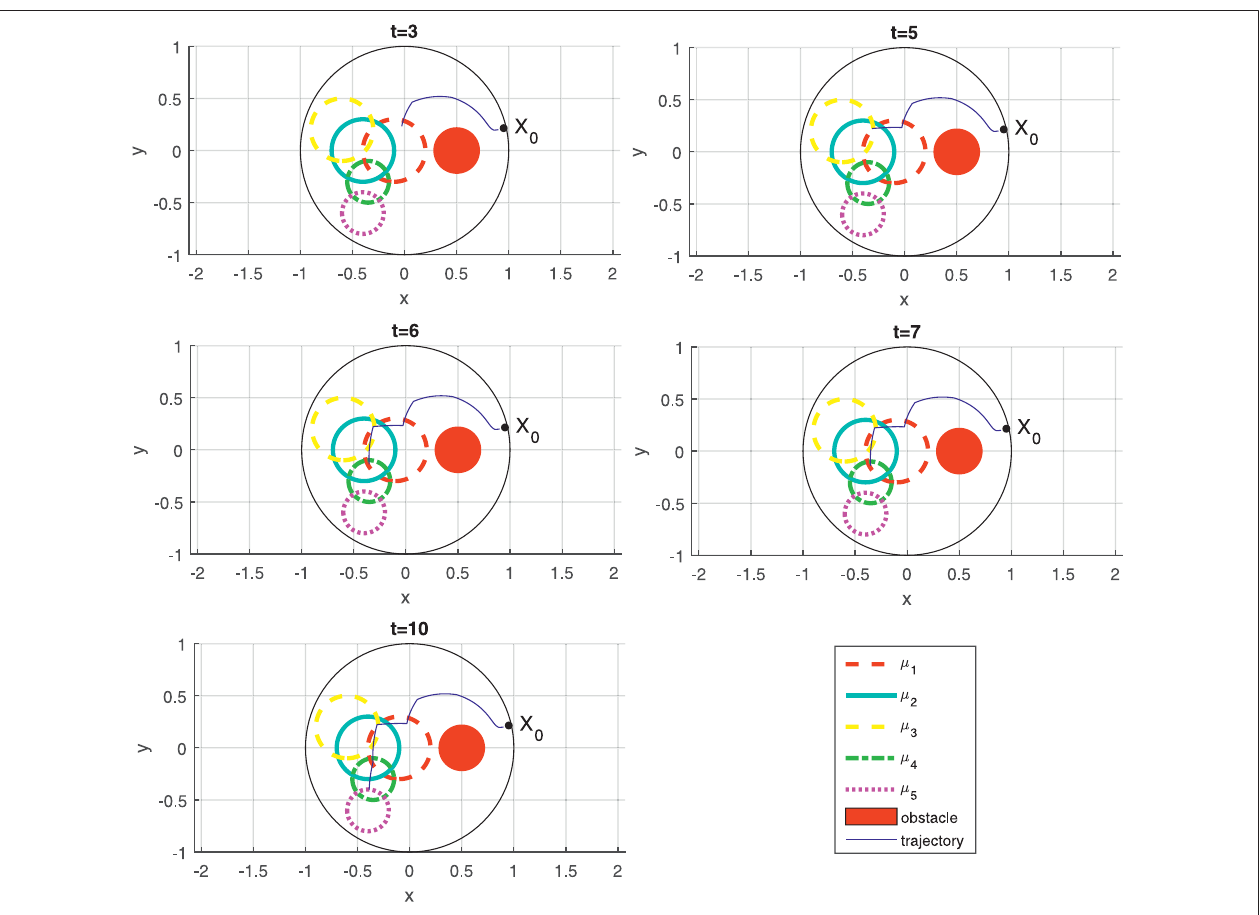
FIGURE1| Pathoftherobotasitiscontrolledtosatisfy STL taskspeci fi cation φ 1 ( 27 ) withsnapshotsat differenttime instances;thetimeinstantisindicated at the top of each sub fi gure.